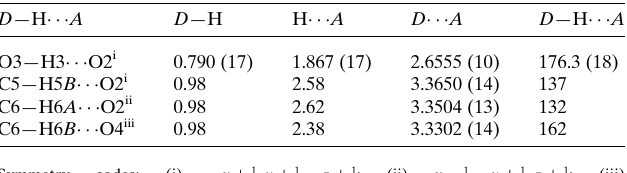
Table 1 Hydrogen-bond geometry (A˚ , (cid:5) ).